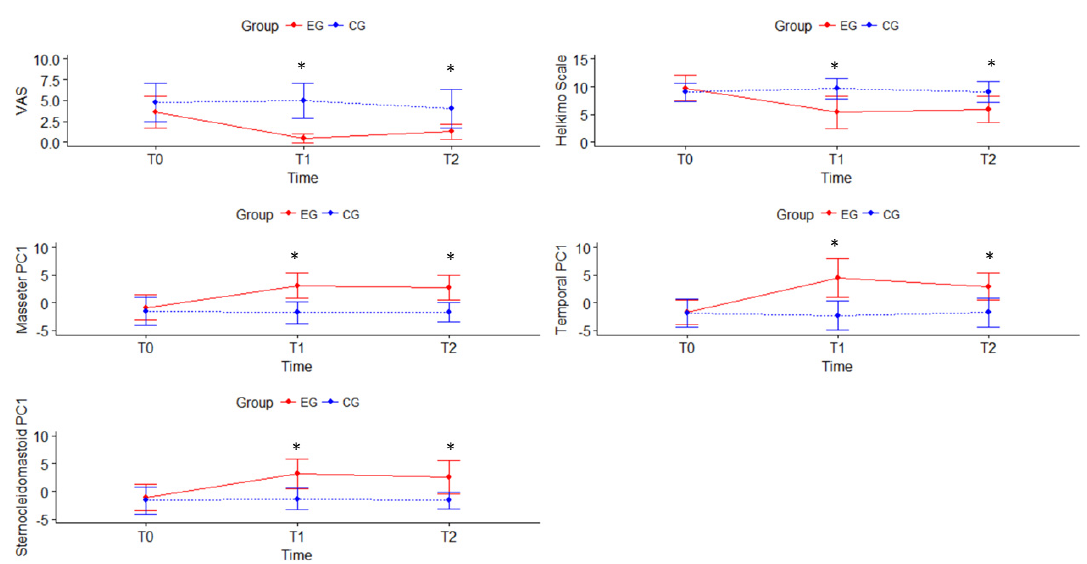
Figure 2. Results of Visual Analogue Scale, Helkimo, and Algometry for Experimental Group (EG) and Control Group (CG). T0 = baseline measurement; T1 = post-treatment measurement; T2 = 1-month follow-up measurement. Algometry shows the Principal Component Analysis (PCA) combining in one variable both sides (left and right) of masseter muscle (MasseterPC1), of temporal muscle (TemporalPC1) and sternocleidomastoid muscle (SternoceidomastoidPC1). * significant differences ( p < 0.05) between groups.